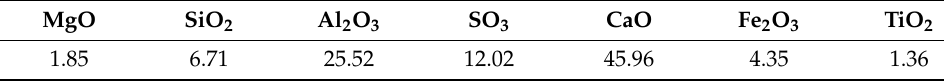
Table 1. Chemical compositions of the CSA cement (wt %).